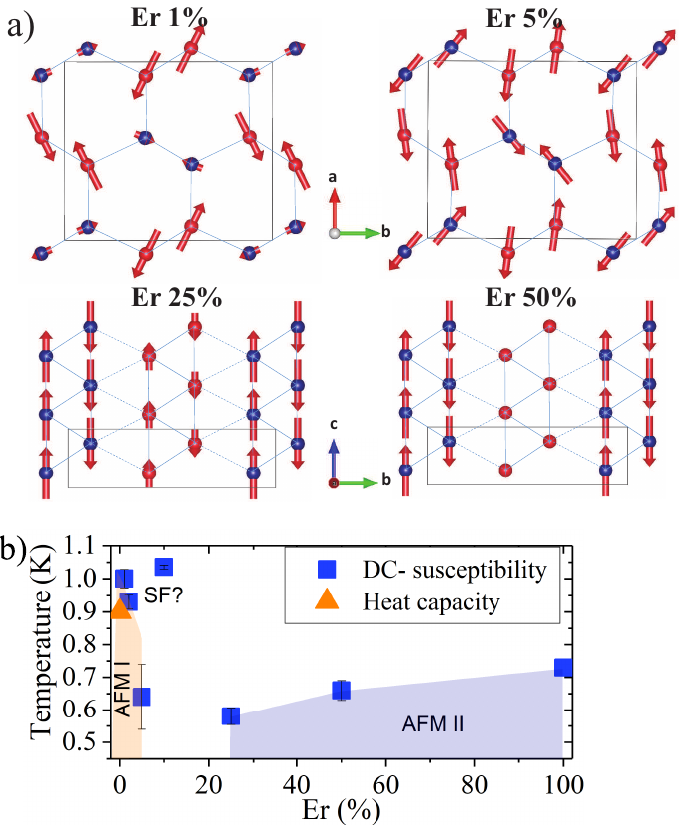
Figure 9. ( a ) Proposed magnetic structures for Er1%, Er5%, Er25%, and Er50% samples. The red circles represent Yb1/Er1 ions and the blue circles represent Yb2/Er2. Magnetic moment directions and lengths are represented by red arrows. The drawings were generated using the software VESTA [17]. ( b ) Magnetic phase diagram as a function of temperature and Er content. The blue squares represent the estimated critical temperatures, obtained from the magnetic DC susceptibility analysis. The data point for Er10% indicates the bifurcation in the susceptibility, SF indicates the hypothesis of a spin–flip or spin glass state for this concentration. The triangle represents the Néel temperature extracted from heat capacity measurements for SrYb 2 O 4 [14]. Critical temperatures for SrEr 2 O 4 were extracted from